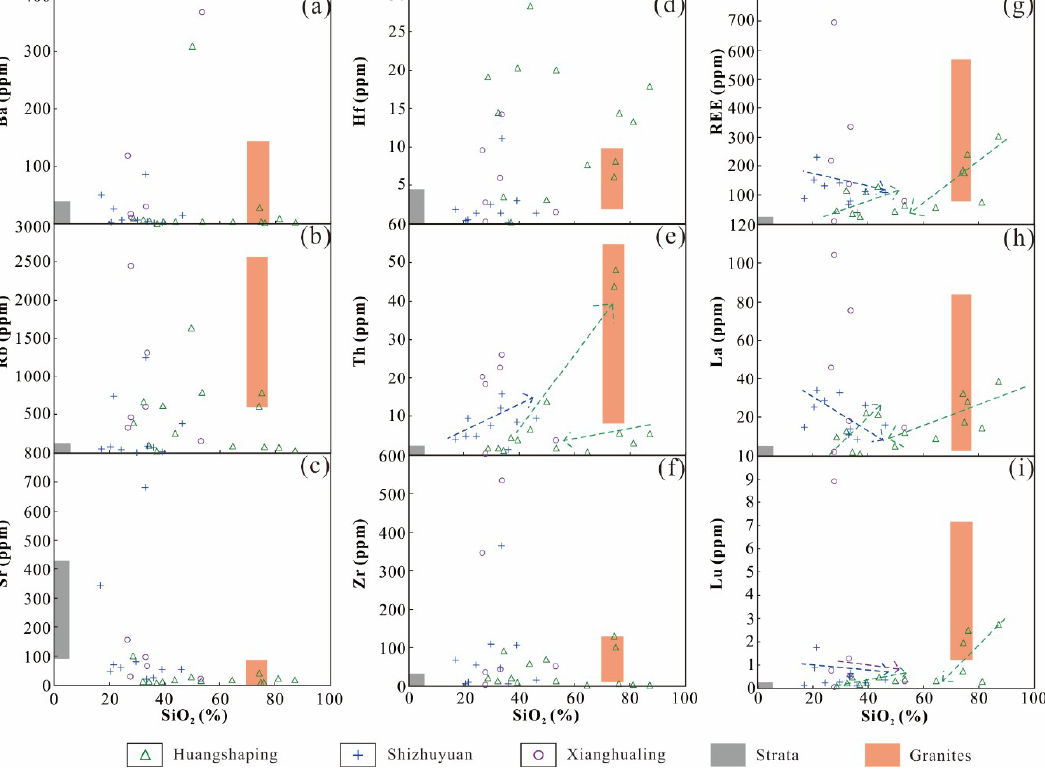
Figure 7. Correlation plots of trace elements vs. SiO 2 in skarns. Colored arrows show correlation trends for skarns (color coded to match data points). ( a ) SiO 2 vs. Ba diagram; ( b ) SiO 2 vs.Rb diagram; ( c ) SiO 2 vs. Sr diagram; ( d ) SiO 2 vs. Hf diagram; ( e ) SiO 2 vs. Th diagram; ( f ) SiO 2 vs. Zr diagram; ( g ) SiO 2 vs. REE diagram; ( h ) SiO 2 vs. La diagram and ( i ) SiO 2 vs. Lu diagram. The orange box shows